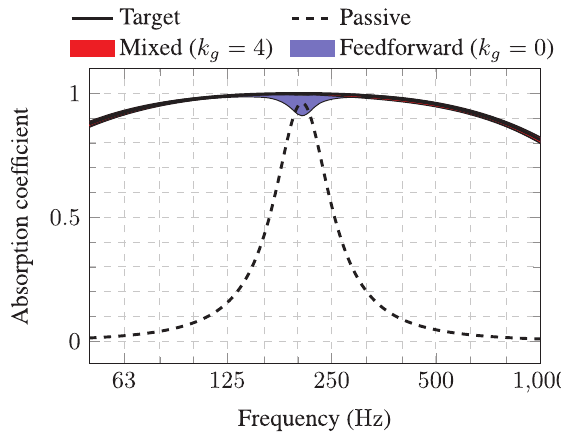
Figure 4. First and third quartiles of the achieved absorption for the broadband absorber with 10 5 random relative errors of 5% standard deviation on the fi ve estimated parameters.